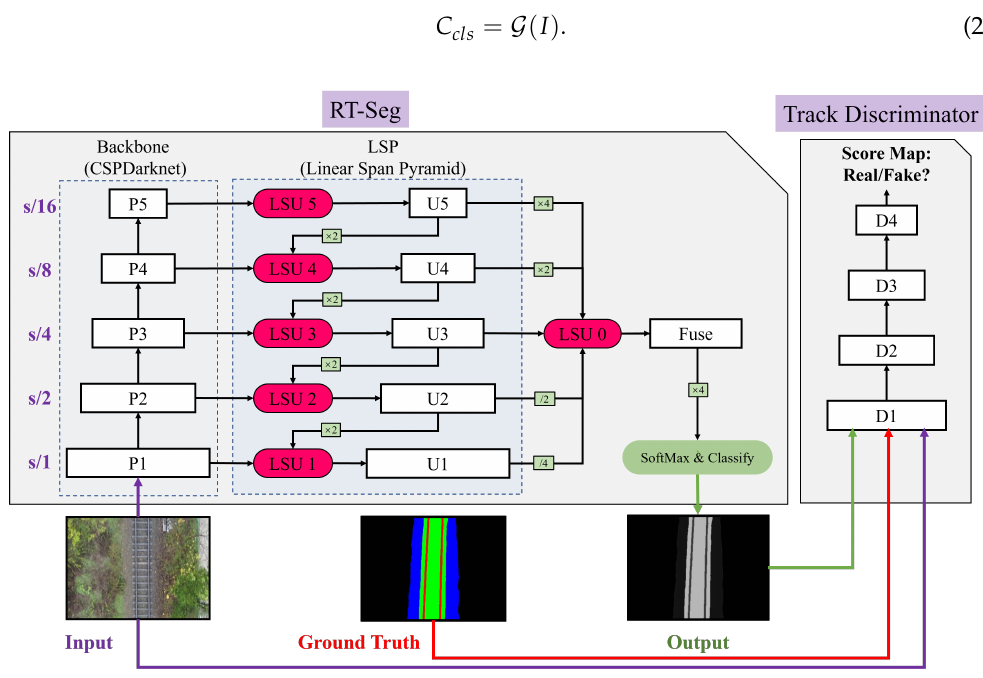
Figure 1. Network structure of